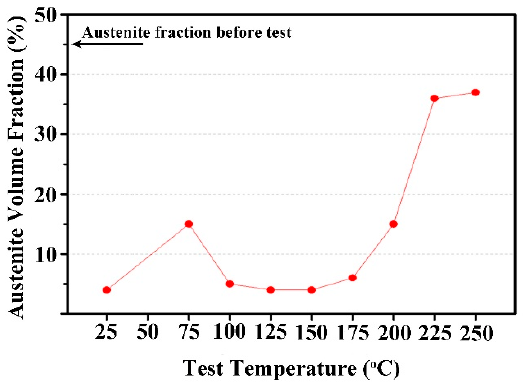
Figure 17. The relationship between austenite volume fraction after tensile test and the test temperature.